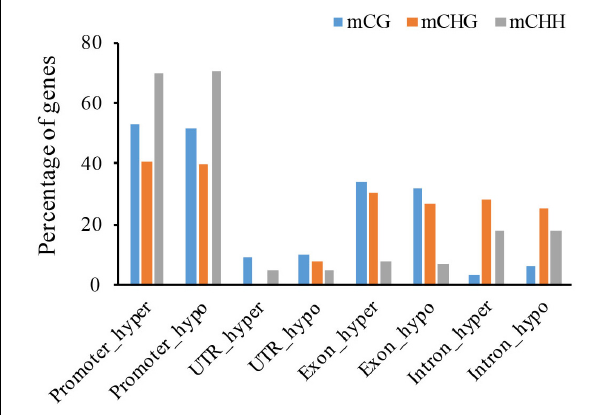
FIGURE 6 | Distribution of hyper- and hypo-DMGs of three cytosine contexts in gene functional regions (promoter, UTR, exon, and